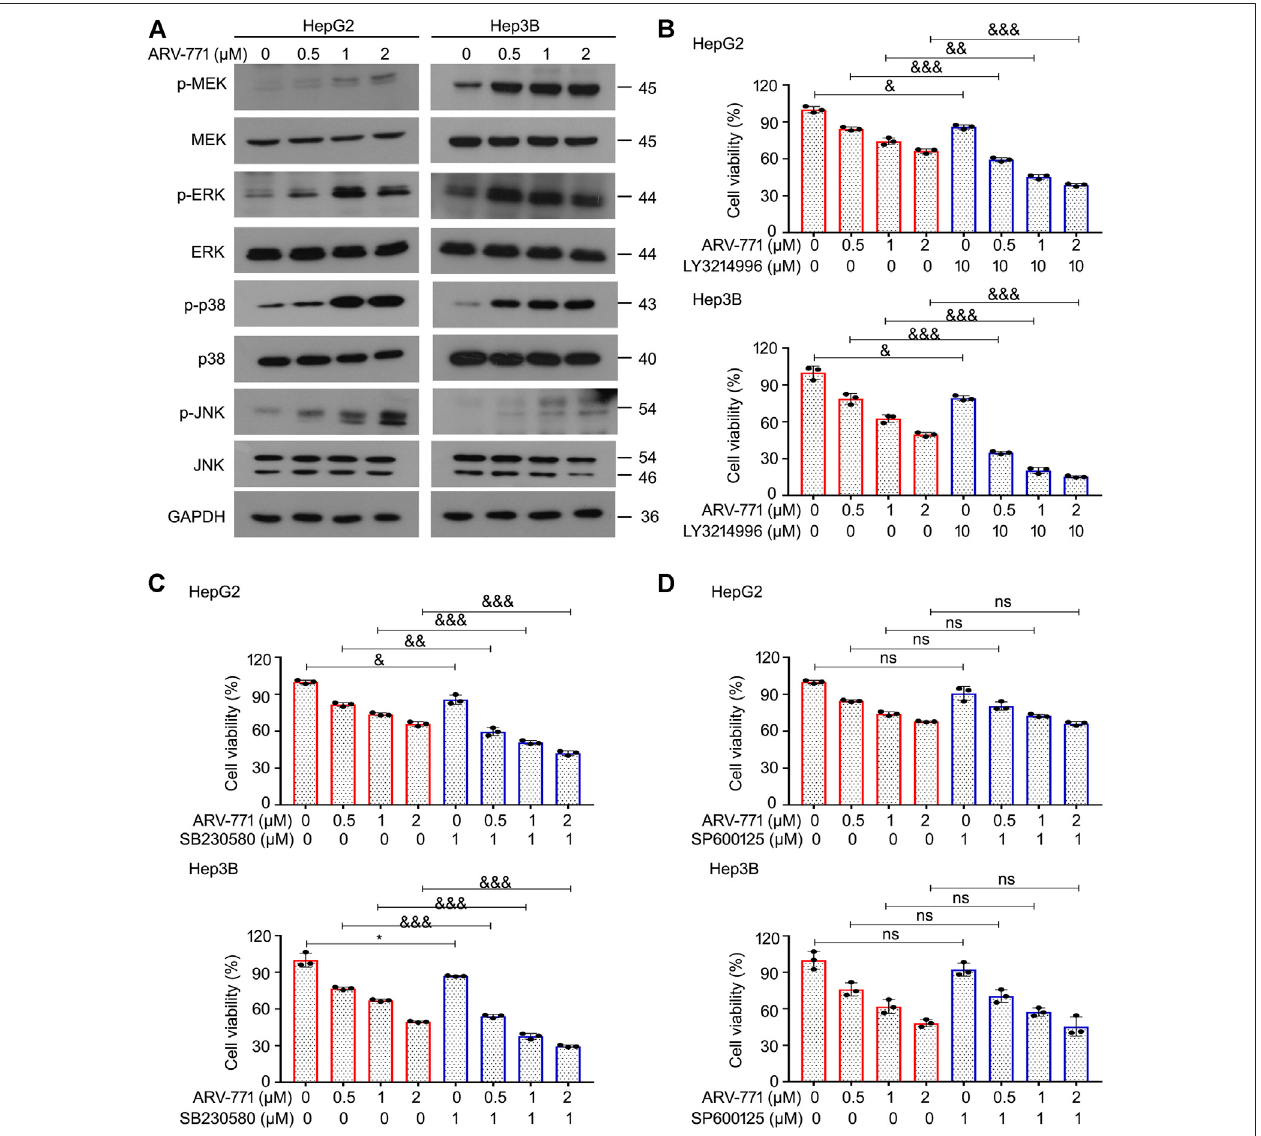
FIGURE 5 | MAPK signaling protects HCC cells from the ARV-771-induced damage. (A) Immunoblot analyses for the indicated kinases were conducted in HCC cells posttheexposureofARV-771 (0.5,1,2 μ M) for24 h (B) – (D) Cellviabilityassayswereconducted inHepG2 and Hep3BcellstreatedwithARV-771 inthepresence or absence of LY3214996, SB230580, and SP600125 for 24 h * p < 0.05, & p < 0.01, && p < 0.001, &&& p <